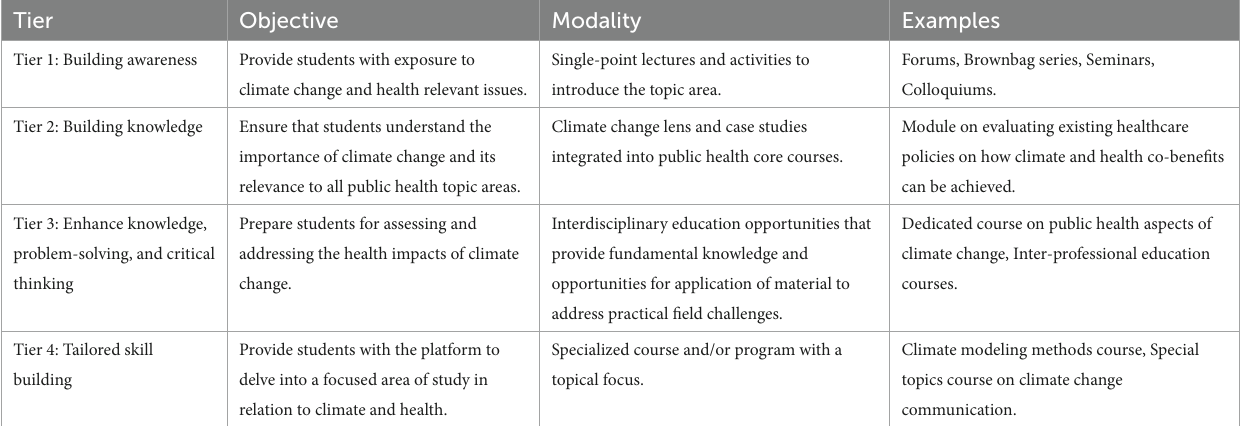
TABLE 2 Proposed climate and health educational